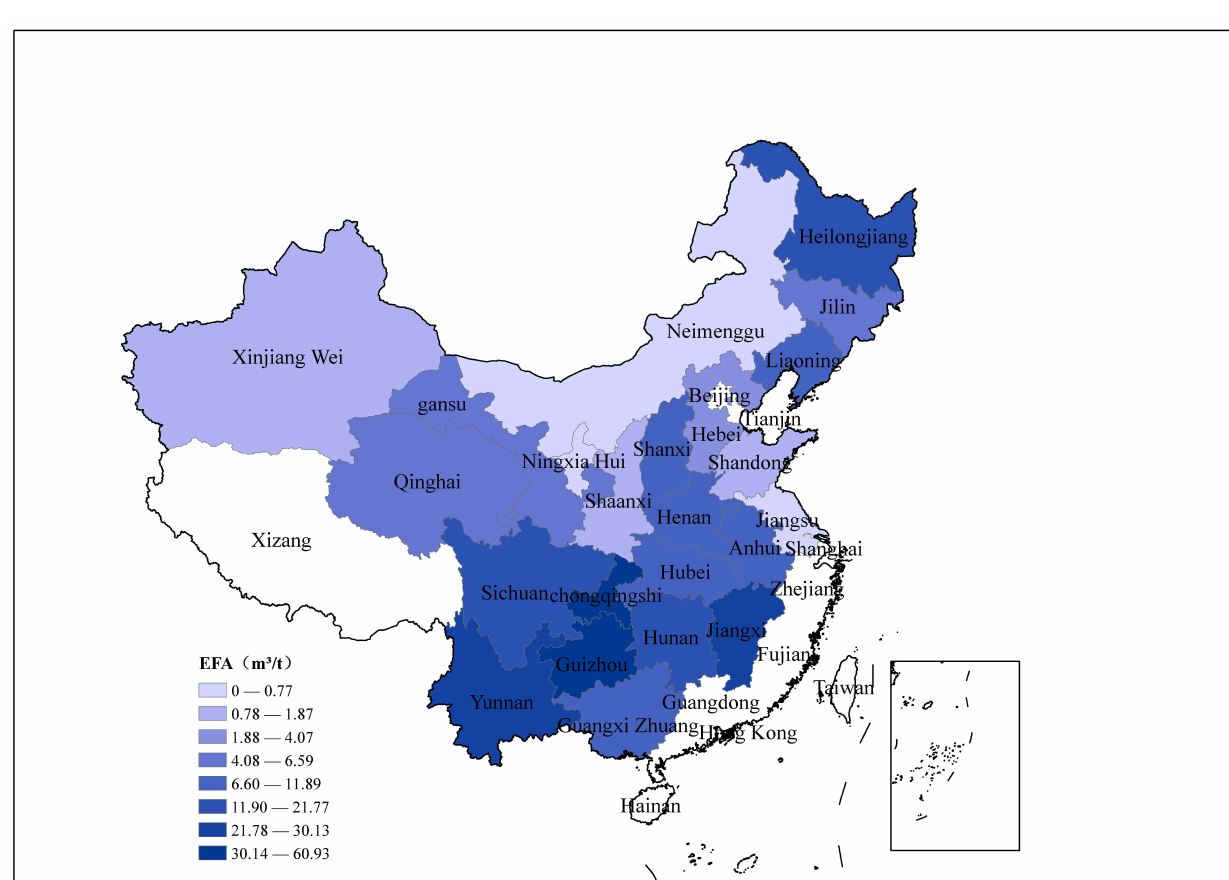
Figure 1. CH 4 emission factors of the coal mining industry in various provinces. In research on the distribution of gas emission factors in China, Zhu obtained a relatively high degree of recognition for the prediction results based on the coal mine gas data of 787 coal mines collected by SACMS in 2009 [18]. Comparing the CH 4 emission factors calculated in this paper with the prediction results of Zhu, the calculation results are generally consistent with the model prediction results of Zhu, except in some provinces such as Chongqing, Jiangxi, and Yunnan, as shown in Figure 2. With the policy on coal mine capacity optimization, provinces in southwest China with complex gas geological conditions have almost stopped building new coal mines. Most of the coal mines in Chongqing, Jiangxi, and Yunnan are old mines. In recent years, with the increased mining depth, the gas content of coal seams has also increased significantly. It also shows that the provinces need to further optimize their coal production capacity and increase CH 4 emission reduction efforts in coal mining